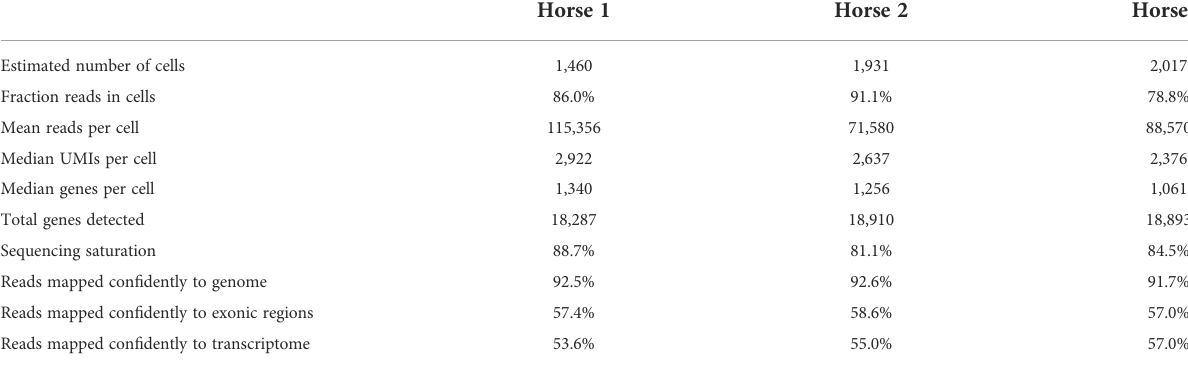
TABLE 2 Summary metrics of the detected cells for each sample.